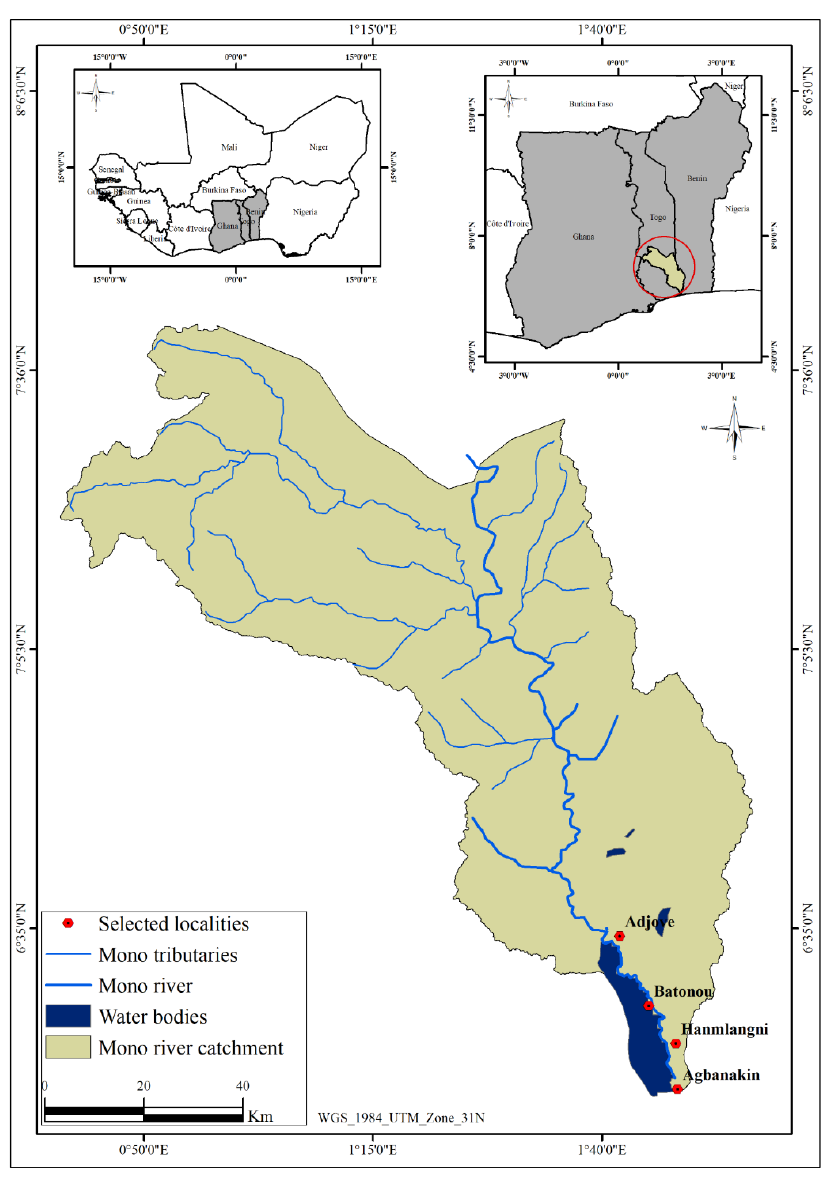
Figure 1. Location of the lower Mono River catchment.